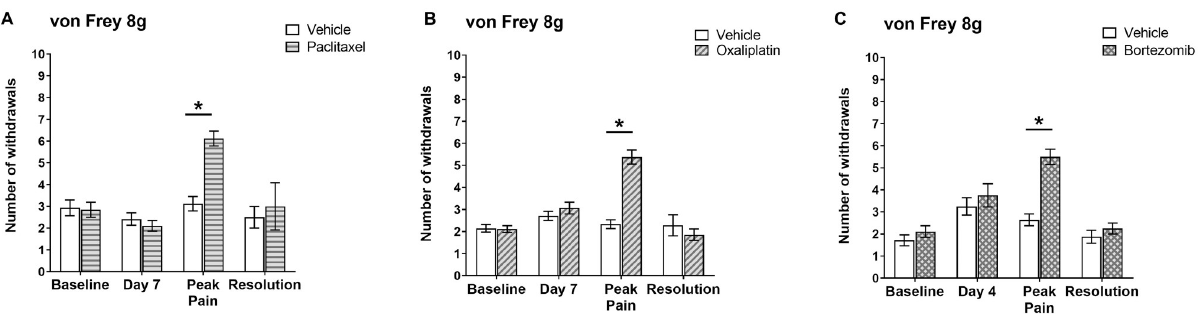
Fig 1. Key time-points of mechanical hypersensitivity before (baseline) and following systemic administration of chemotherapy. Graphs show mechanical hypersensitivity to von Frey filaments 8g. (A) Mechanical hypersensitivity after systemic administration of 2 mg/kg paclitaxel or vehicle solution on four alternate days (0, 2, 4 and 6). Baseline and day 7: n = 29 per group; peak pain (day 28–31): n = 17 per group; resolution (day 174): n = 4 per group. (B) Mechanical hypersensitivity after systemic administration of 2 mg/kg oxaliplatin or vehicle solution on four alternate days (0, 2, 4 and 6). Baseline and day 7: n = 31 per group; peak pain (day 27–29): n = 21 per group; resolution (day 147–148): n = 7 per group. (C) Mechanical hypersensitivity after systemic administration of 0.2 mg/kg bortezomib or vehicle solution on four alternate days (0, 3, 4 and 6). Baseline: n = 20 per group; day 4: n = 12 per group; peak pain (day 23–25): n = 14 per group; resolution (116–124): n = 8 per group. Data are expressed as mean ± SEM of number of withdrawals to 10 stimulations in total. � p < 0.05, two-tailed multiple-comparison unpaired t -tests with Holm-Sidak correction. Sample size decreases over time as some animals were sacrificed at day 7 and peak pain to perform experiments on mtDNA levels and Complex I